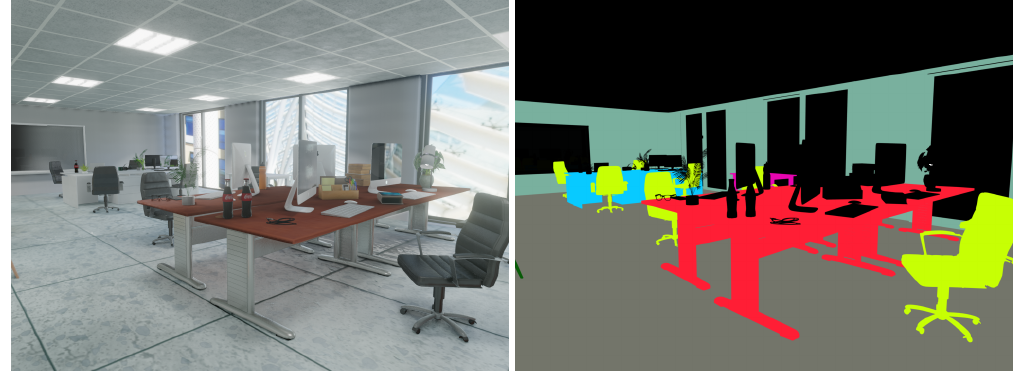
Figure 10. Semantic segmentation image (right) corresponding to an RGB image (left). The black colour is a random object, and instances with the same class label are marked in the same RGB